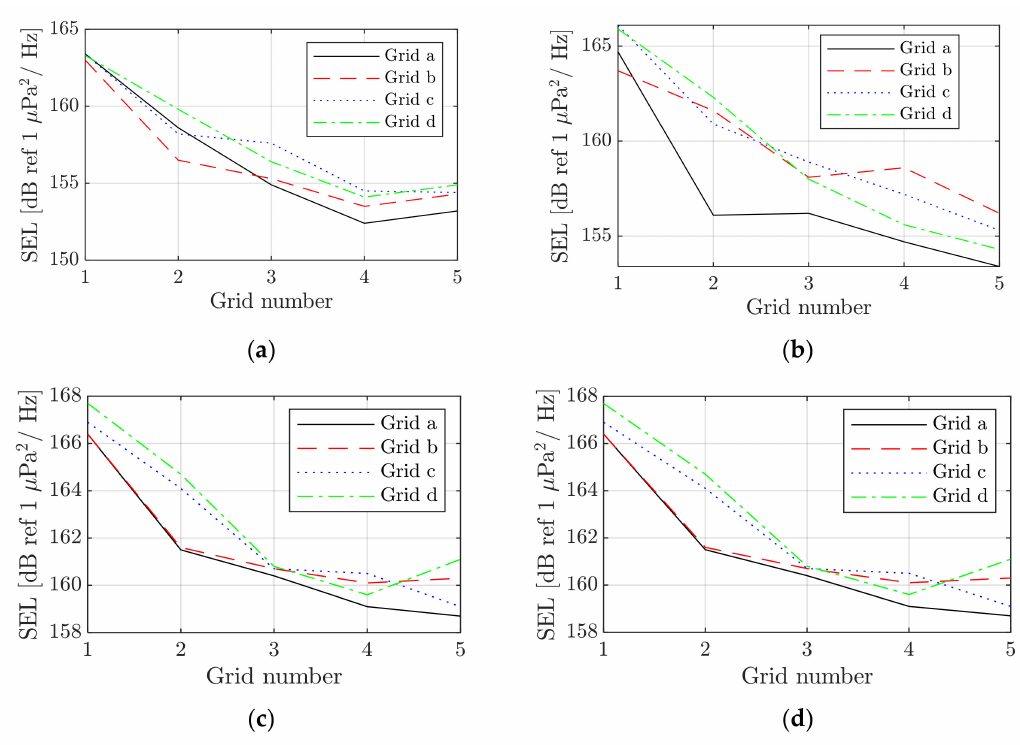
Figure 14. Sound exposure levels (SELs) calculated for ( a ) stage 4, ( b ) stage 5, ( c ) stage 6, and ( d ) stage 7.